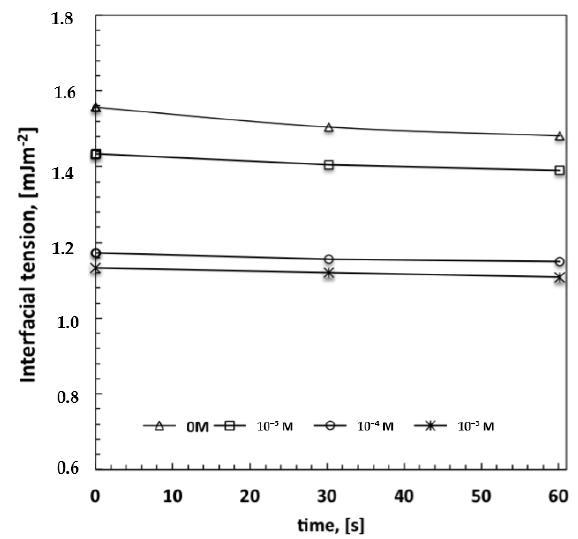
Figure 5. Estimation of interfacial tension values between a water droplet and polymeric solution containing increasing amount of surfactant.